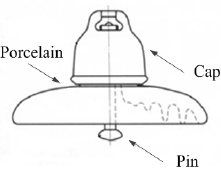
Figure 3. Structure of a cap and pin insulator.